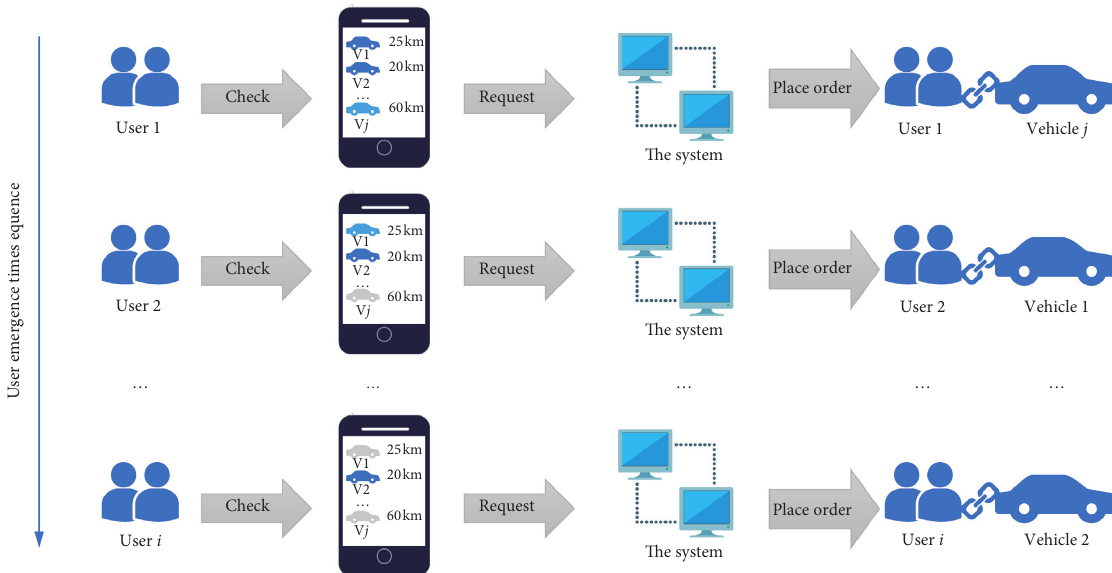
Figure 2: User interaction and vehicle selection of instant access mode.